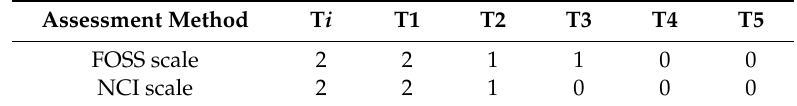
Table 5. Results of the assessments of oral mucositis using the national cancer and dysphagia using the functional outcome swallowing scale for staging oropharyngeal